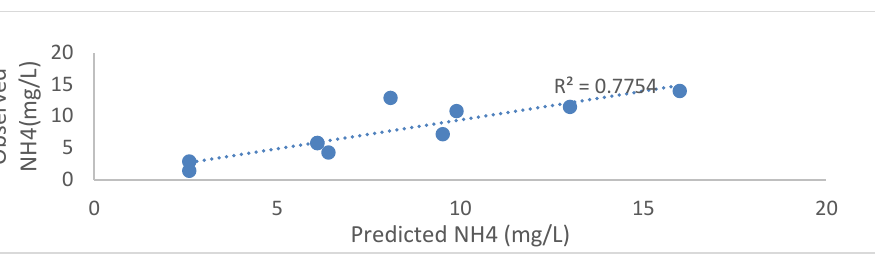
Fig. 3. Comparison between observed and predicted COD.